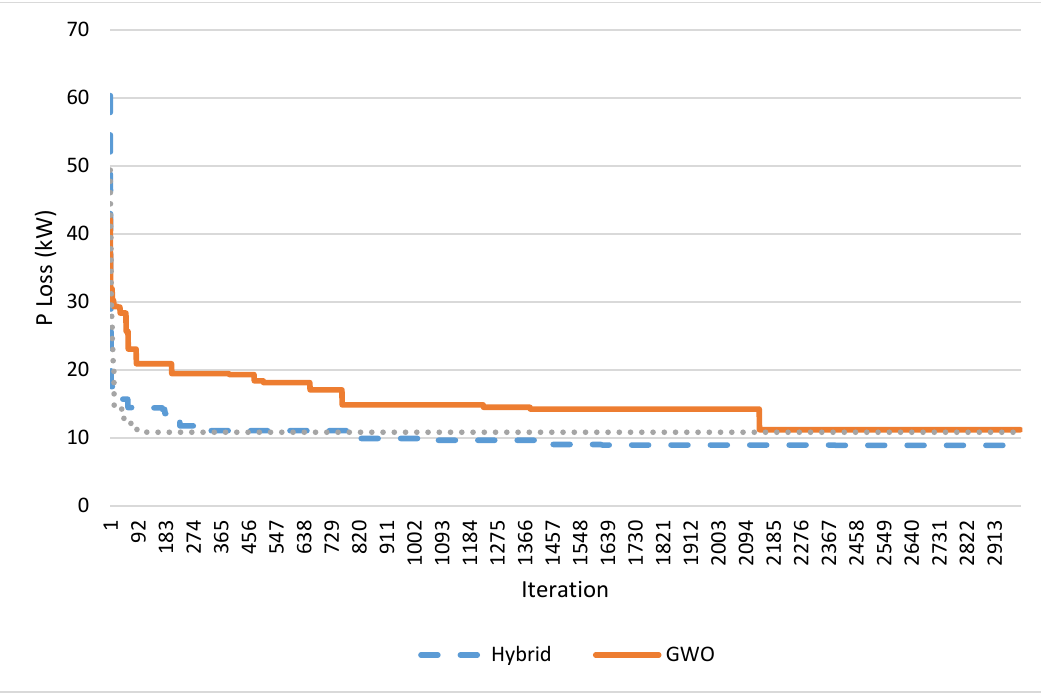
Figure 7. Conversion curve of a 33-bus system using three different techniques for scenario 8. Table 4. Comparison of methods performance for the 33-bus system.